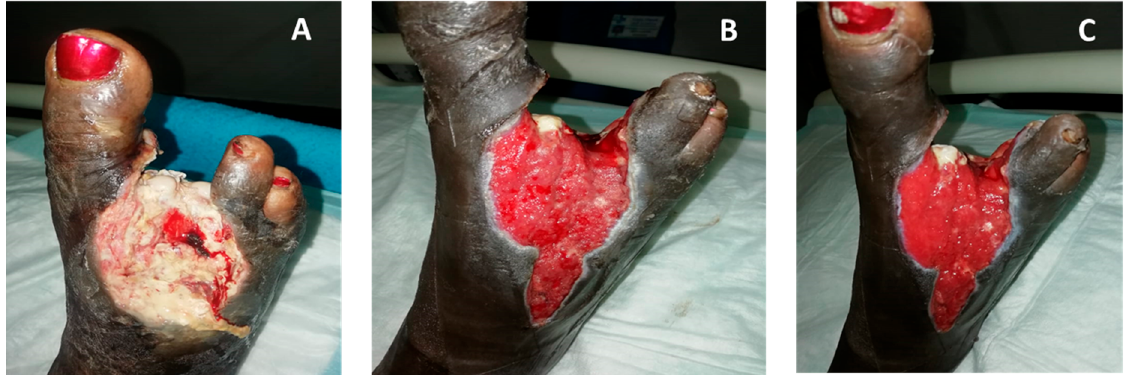
Figure 8. Dense granulation following surgery in a diabetic patient with peripheral vascular disease (PVD) (Case Report 6). ( A ) One day post-surgery, the wound started to be treated with COD. ( B ) Twelve days post-surgery, very significant granulation tissue was observed despite the PVD. ( C ) After 18 days of COD treatment the wound was ready for second tarsal nibbling and skin graft on dorsal foot.